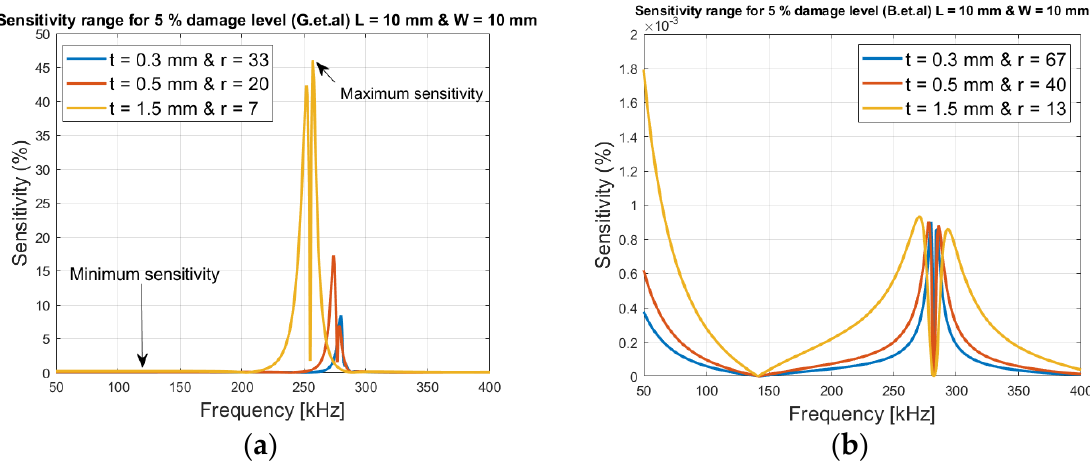
Figure 6. Sensitivity levels with respect to thickness variations ( a ) Giurgiutiu’s et al.’s model ( b ) Baptista et al. model.